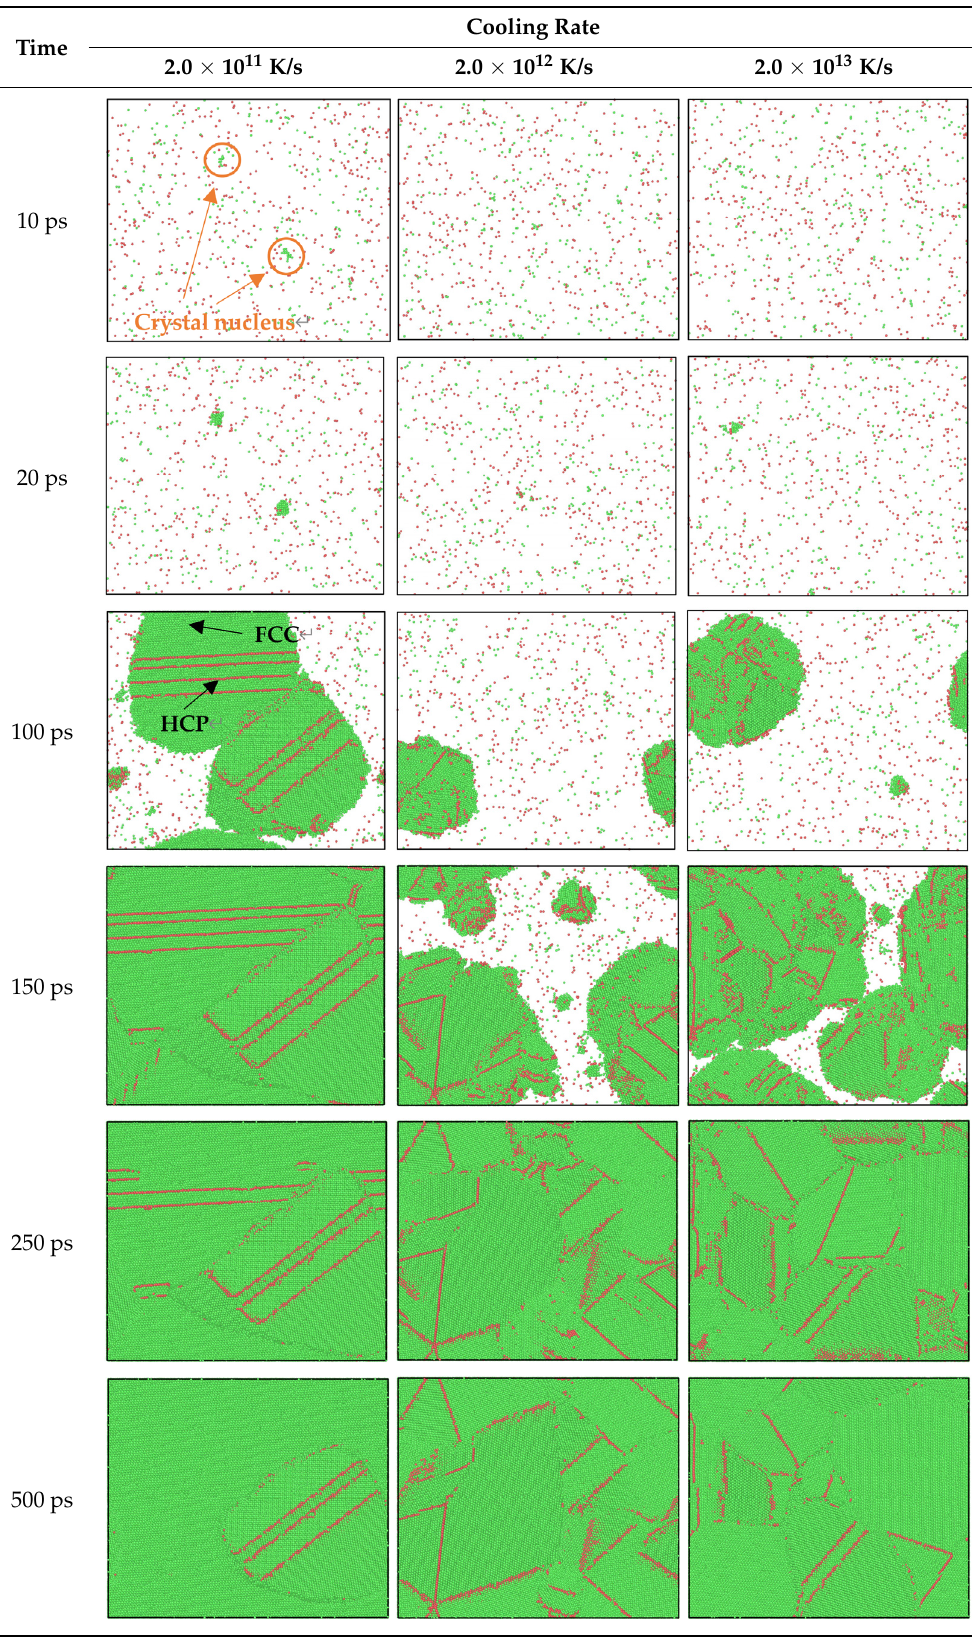
Table 3. Nucleation and growth during the isothermal solidification process after cooling with different cooling rates.